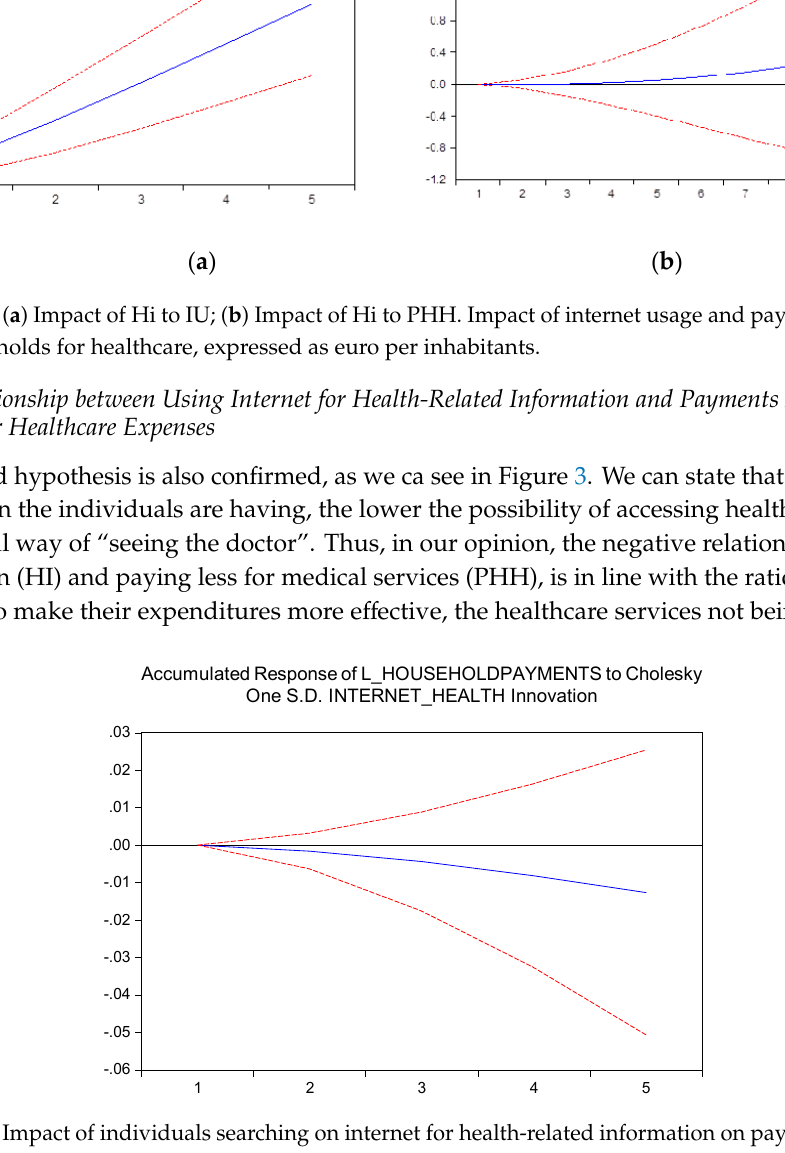
Figure 4. Impact of payments made by households for healthcare, expressed as euro per inhabitants on knowledge-intensive activities.